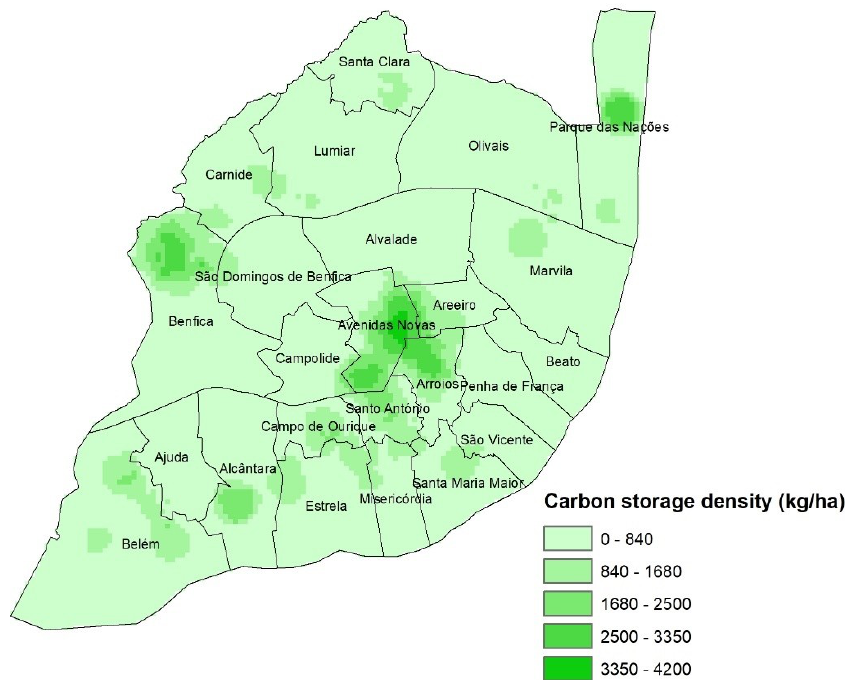
Figure 6. Spatial distribution of carbon storage density in the city of Lisbon in kg/ha.